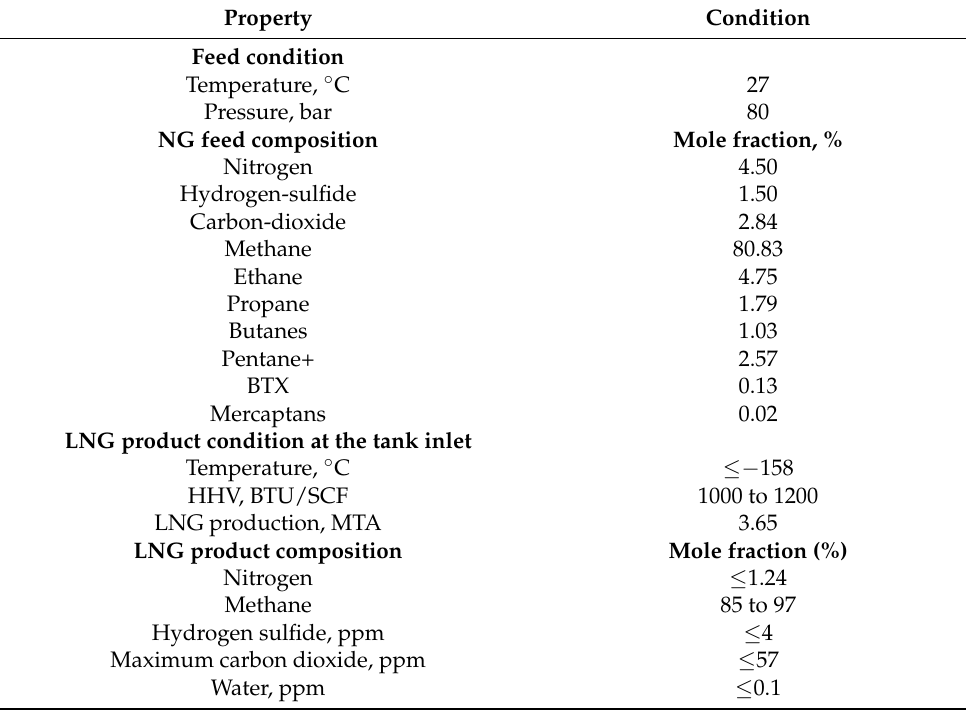
Table 1. Chain feed conditions and LNG product specifications at the export terminal tank